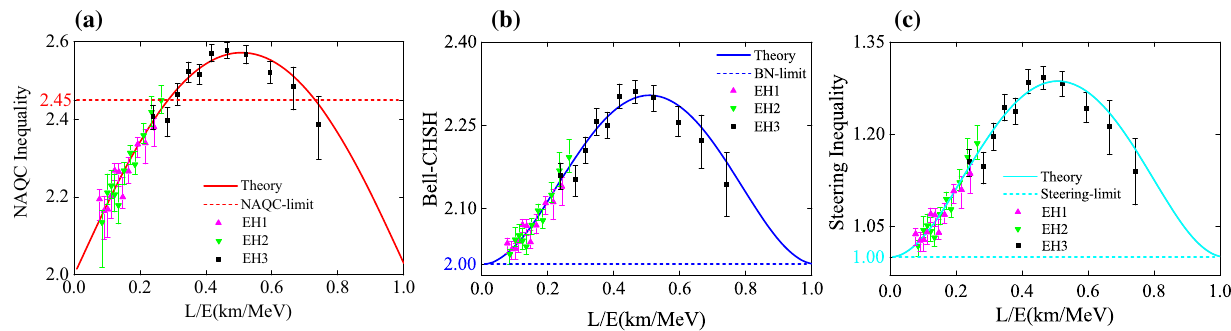
Fig. 2 NAQC inequality in Eq. (9), Bell-CHSH inequality in Eq. (11), and steering inequality in Eq. (13) in theory and experiment with error bars versus the distance traveled per energy L / E for the initial electron flavor state. The red line (solid), the blue line (solid), and the azure line (solid) correspond to the left-hand sides of Eqs. (9), (11) and (13),